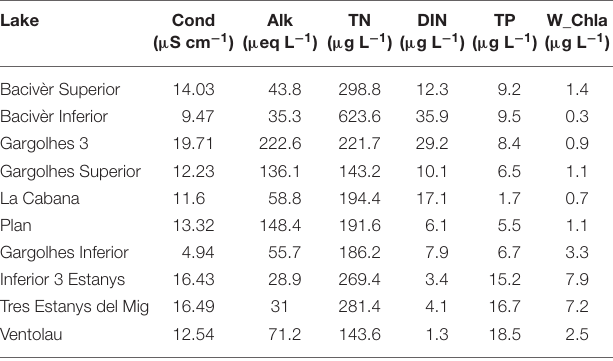
TABLE 2 | Biogeochemical variables considered for the studied lakes. Lake